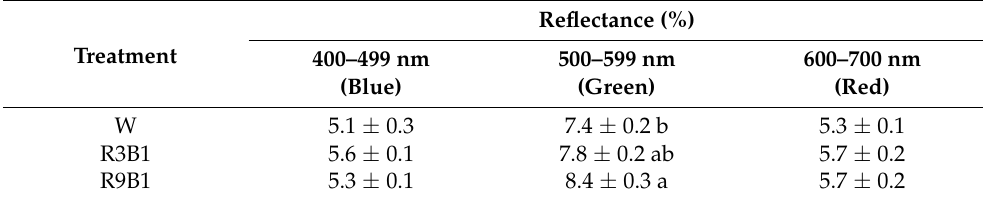
Table 9. Effect of light quality on the reflectance of leaves in ‘Micro-Tom’ at blue, green, and red wavelengths 10 DAT in Experiment 2. The range of the measured light spectrum was 400–700 nm. Each value represents the mean ± standard error. Different letters in a column indicate significant differences among the treatments based on Tukey − Kramer’s test at p < 0.05 ( n = 4). The PPFD of three ratio =